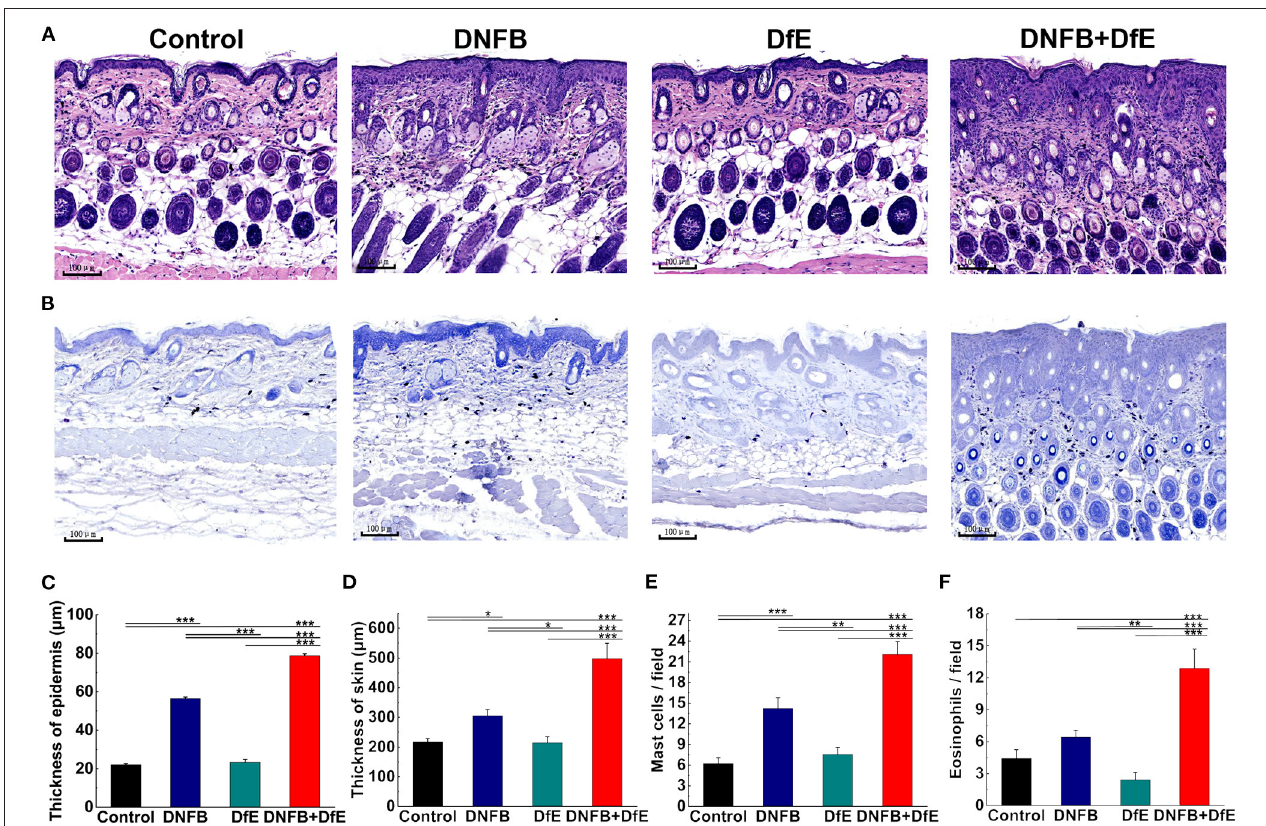
FIGURE 2 | Skin dermatitis got largely promoted after 8 weeks of alternate application of DNFB and DfE. (A) Hematoxylin and eosin (H&E) staining; (B) Toluidine blue staining. (Scale bar = 100 µ m); (C) Epidermal thickness; (D) Thickness of skin, including the epidermis and the infiltration depth of inflammatory cells in the dermis; (E) The average number of mast cells per field of 0.250 × 0.250 µ m; (F) The average number of eosinophils per field of 0.250 × 0.250 µ m. The number of mast cells and eosinophils is representative of three mice in each group ( n = 4 mice). All data were measured using the iviewer image analysis software. Data are shown as mean ±